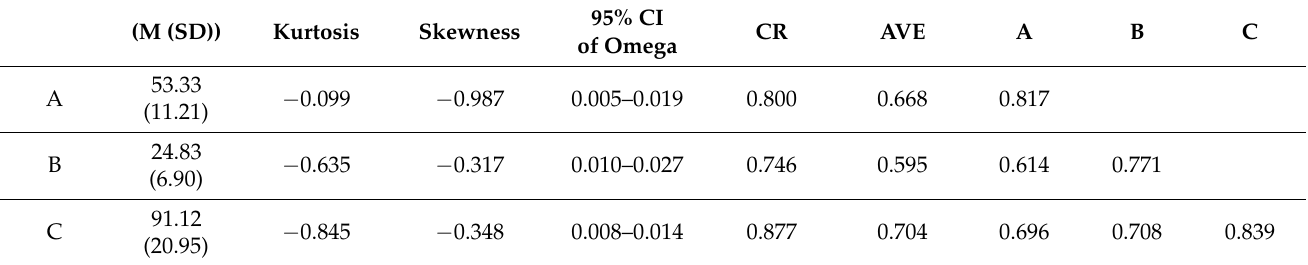
Table 3. Specific evaluation indicators for the Self-Supporting Ability